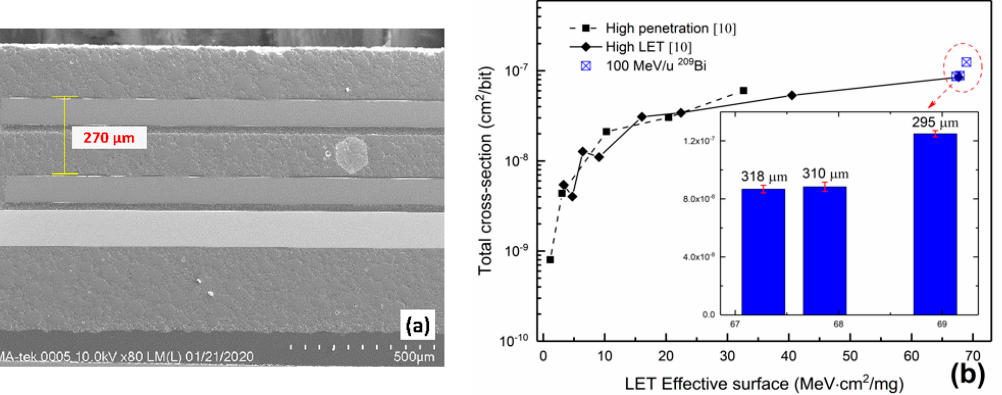
Figure 10. ( a ) SEM image of CY62177EV30; ( b ) SEU CS of this CY62177EV30 as a function of LET obtained by Gupta et al. (the black solid point) and our experiment (the blue hollow point).